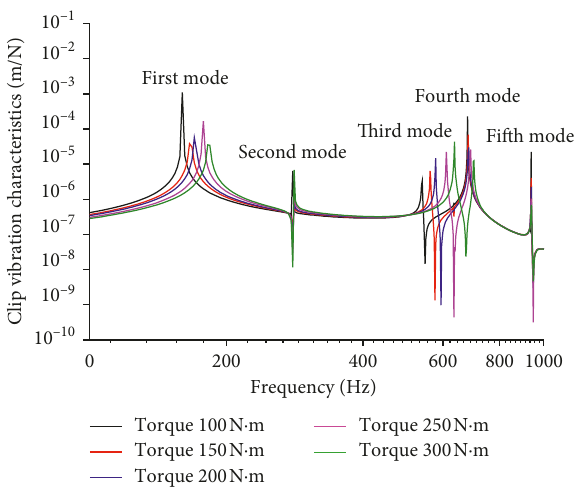
Figure 9: Simulated results of the clip modal